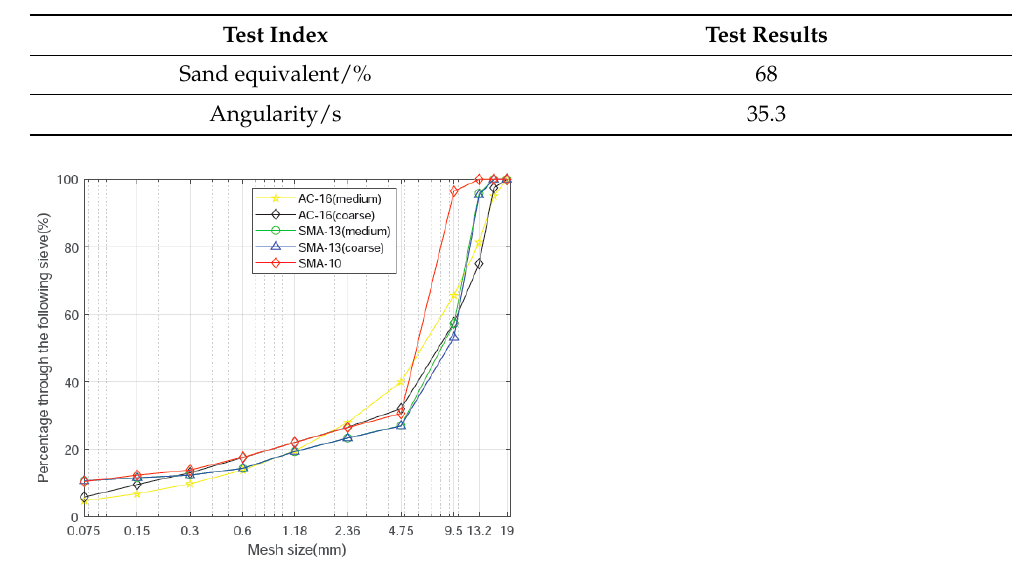
Table 3. Fine aggregate technical index test results.